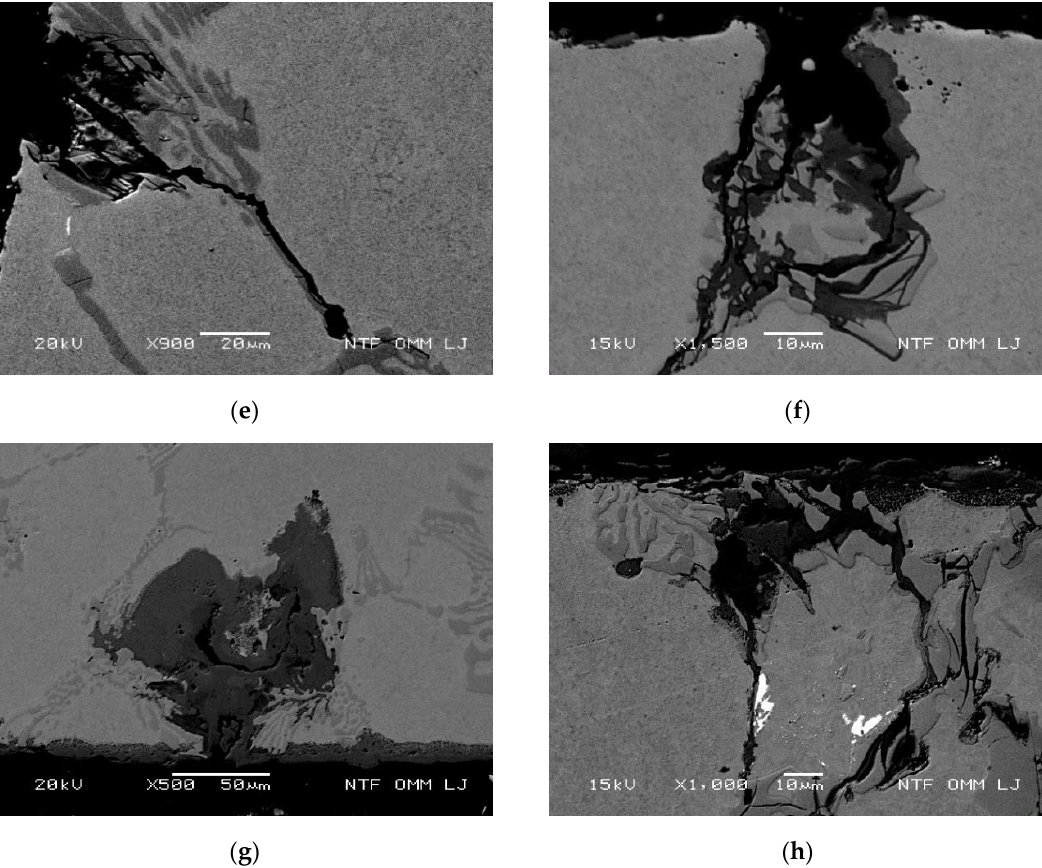
Figure 5. Oxidation behavior at the cooled surface and cracked eutectic carbides: ( a ) initial eutectic cracking after 1000 cycles at 500 °C, and ( b ) higher magnification of the window in subfigure a. Initial oxidation around the cracked eutectic carbide at 600 °C: ( c ) after 1000 cycles and ( d ) after 2500 cycles. Observed oxidation around the eutectic carbides after 2500 cycles: ( e ) at 500 °C, ( f ) at 600 °C and ( g , h ) at 700 °C with severely oxidized areas.